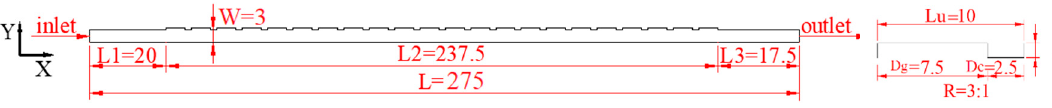
Figure 4. Schematic diagram of computational model (all dimensions in mm).